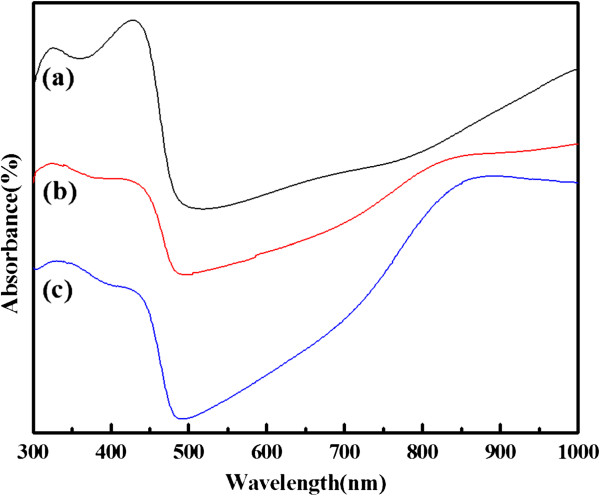
UV-vis spectra. Curves (a) PANI, (b) PANI(HAuCl4·4H2O), and (c) PANI(H2PtCl6·6H2O).